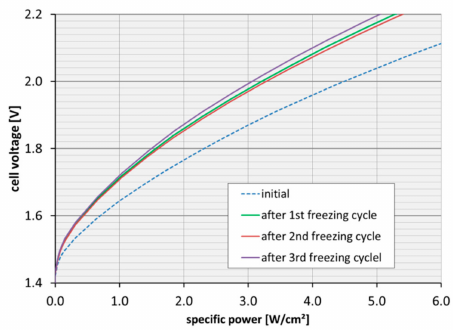
Figure 9. Performance of PEM electrolysis before and after